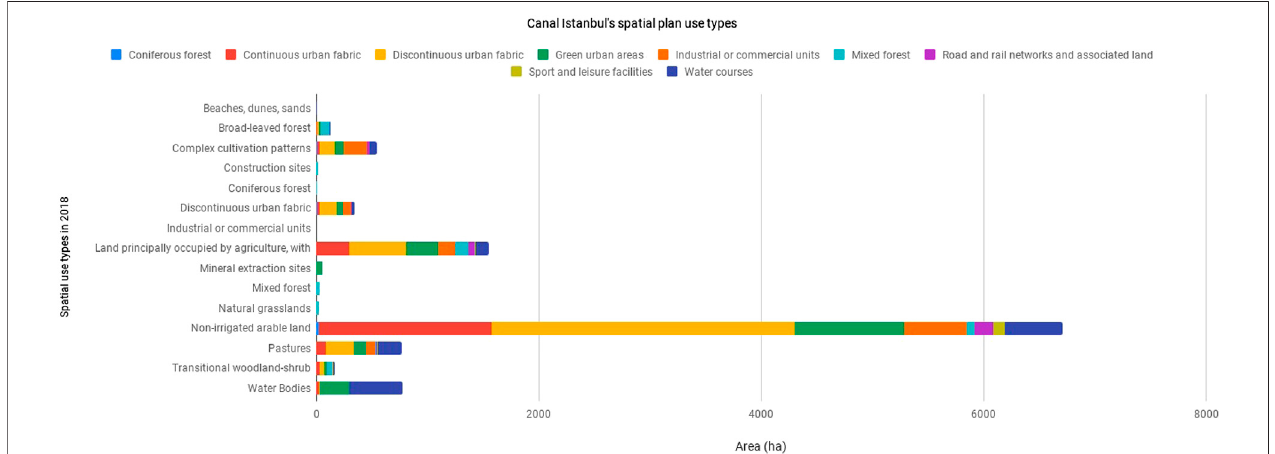
FIGURE 7 | Corine Land Cover Classes in Canal Istanbul ’ s planning extent.